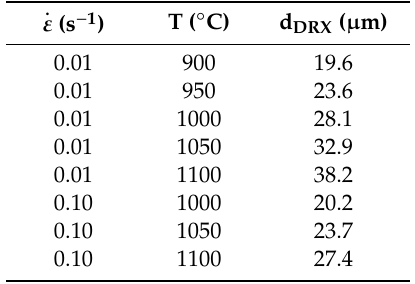
Table 5. Dynamic recrystallized grain size under various deformation conditions.